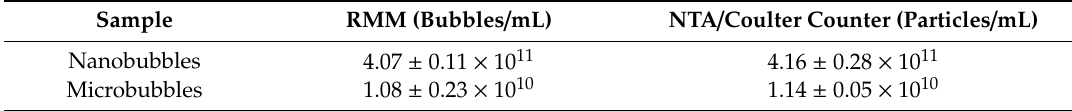
Table 1. Comparison of bubble concentrations measured using RMM, NTA, and Coulter counter.